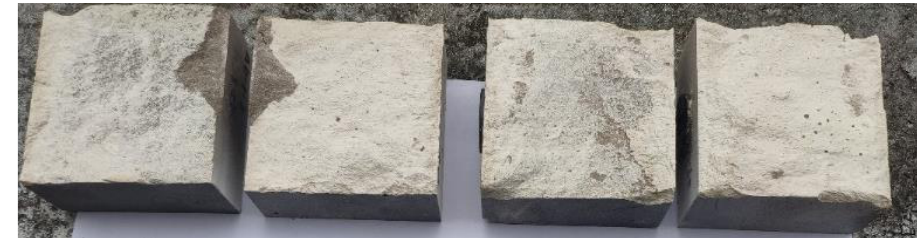
Figure 13. Failure surfaces of AD-1 and AD-2 after the first shearing.